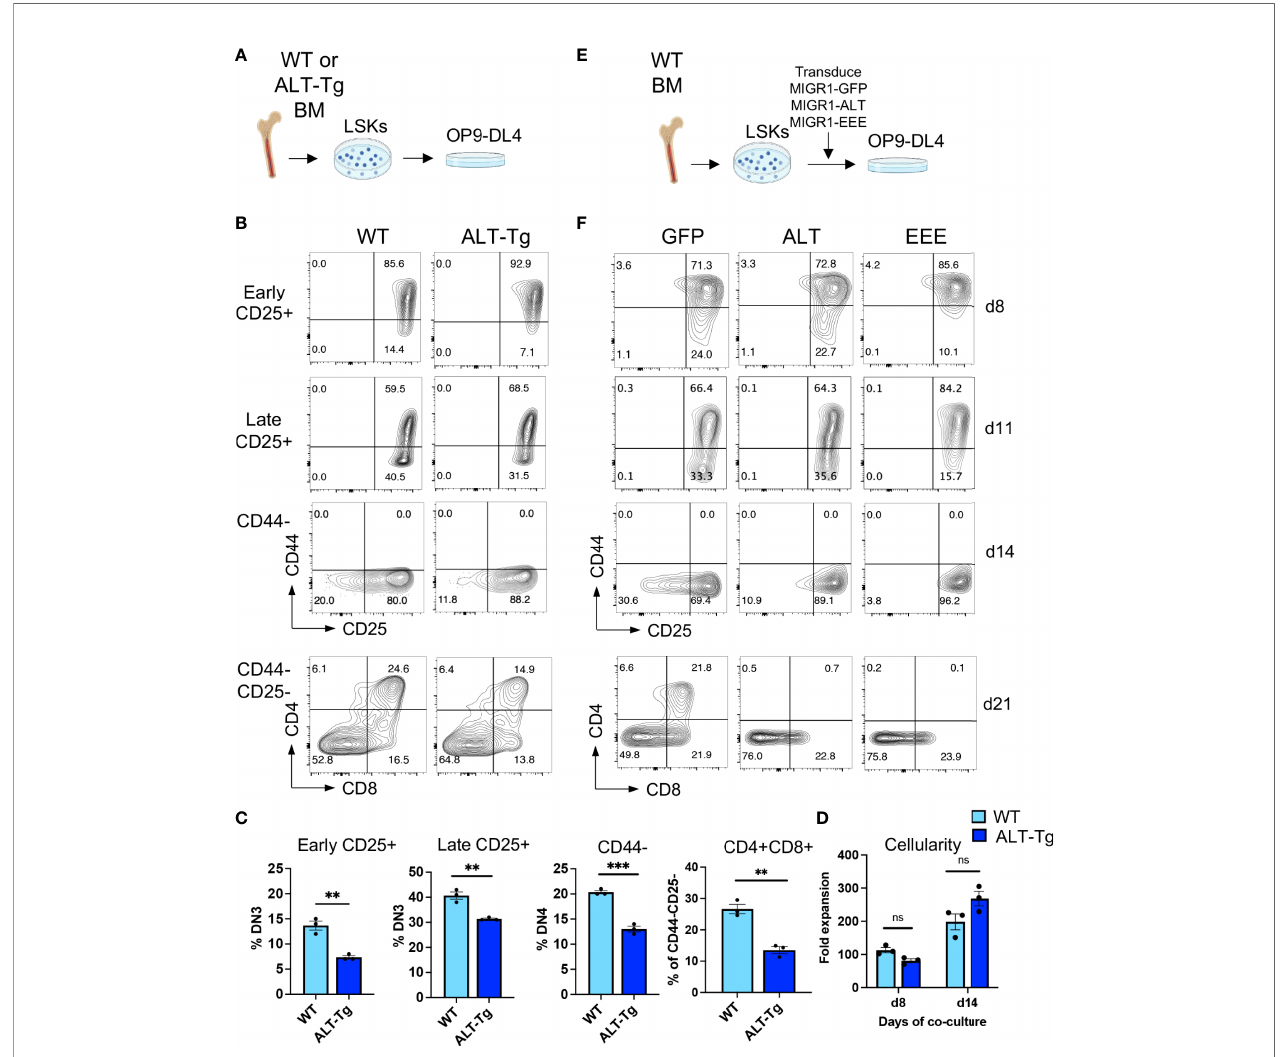
FIGURE 9 | Unrestrained activity of HEBAlt inhibits progress through T cell development. (A) Diagram of experimental procedure using precursors from ALT-Tg mice. (B) Flow cytometry analysis of progression through T cell development by bone marrow-derived LSKs from ALT-Tg mice co-cultured on OP9-DL4 cells. Gates are shown to the left of each plot. (C) Quanti fi cation of the populations de fi ned by fl ow cytometry in (C) . (D) Fold expansion of cells after 8 or 14 days of OP9-DL4 co-culture. (E) Diagram of experimental procedure using precursors from WT mice transduced with retroviral vectors encoding GFP (vector only), ALT, or EEE. (F) Flow cytometry analysis of T cell development. Gates are the same as shown in (B) . **P < 0.001, ***P < 0.0001, ns, not signi fi